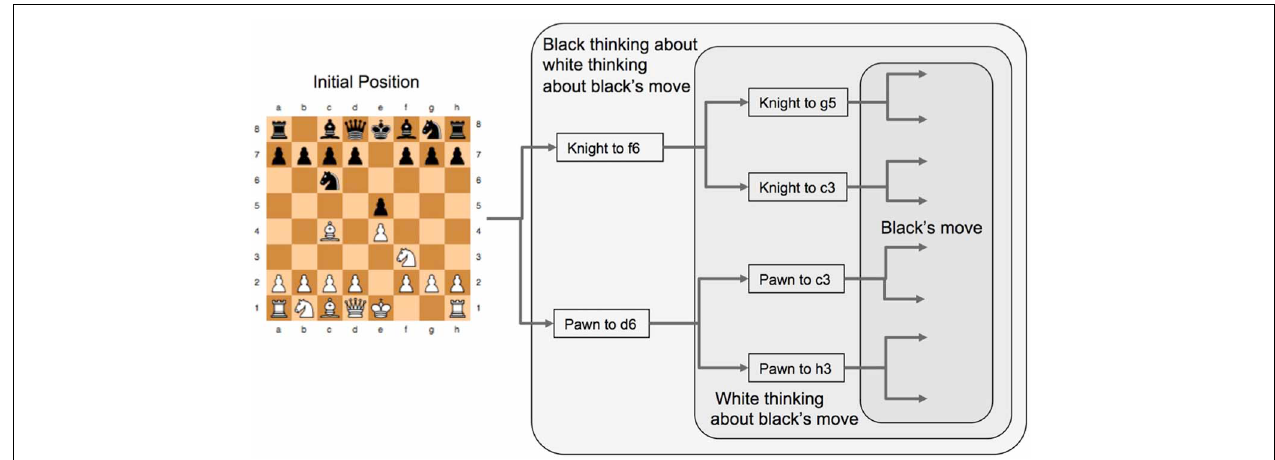
FIGURE 5 | The game tree for forward search in a game. Black is to play first from the initial position and the tree analysis is simplified to considering only two possible branches at each stage. Knight to f 6 and Pawn to d 6 are two different “base moves” from which black then begins their analysis of subsequent play. In order for black to estimate the success of these two base moves they need to consider how White will reply, and the way White will reply depends on how white evaluates how black will reply to White’s moves, hence Black needs to evaluate how white will evaluate Black’s reply to